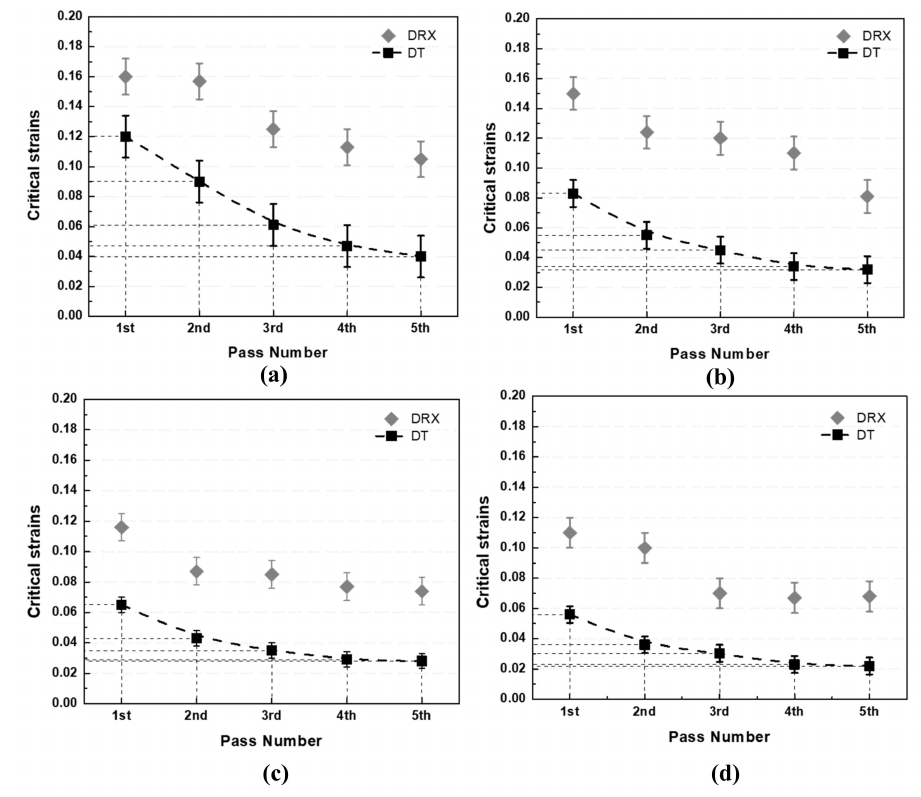
Figure 6. The dependence of critical strains for dynamic transformation (DT) and dynamic recrystallization (DRX) on the finishing pass number. Simulations with roughing number of ( a ) zero, ( b ) one, ( c ) two and ( d ) four are shown. Here the first finishing pass always displays the highest critical strain, and this critical value is reduced with increasing roughing pass